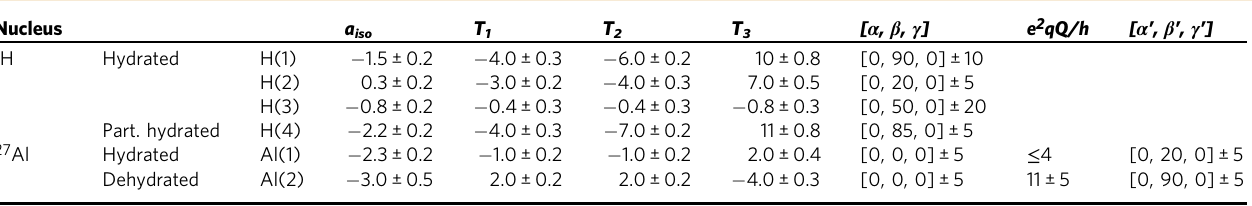
Table 2 Experimental 1 H and 27 Al hyper fi ne coupling components and quadrupolar coupling constants used for the simulations of HYSCORE and ENDOR spectra in Fig.